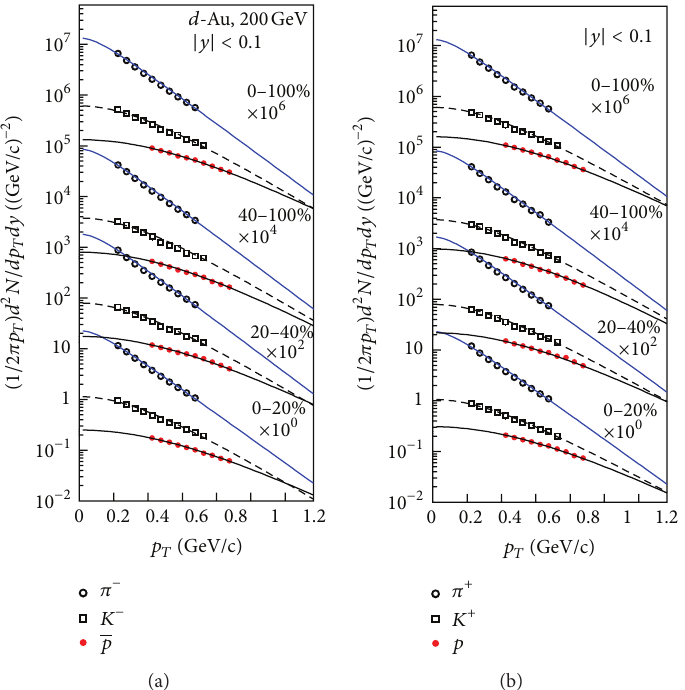
Figure 3: The transverse momentum distributions of (a) 𝜋 − , 𝐾 − , and 𝑝 as well as (b) 𝜋 + , 𝐾 + , and 𝑝 produced in d -Au collisions at √𝑠 𝑁𝑁 = 200 GeV with |𝑦| < 0.1 and different centrality classes and magnifications are shown in the figure. The symbols represent the experimental data of the STAR Collaboration [26] and the curves are our results calculated by the Boltzmann or two-component Boltzmann distribution.